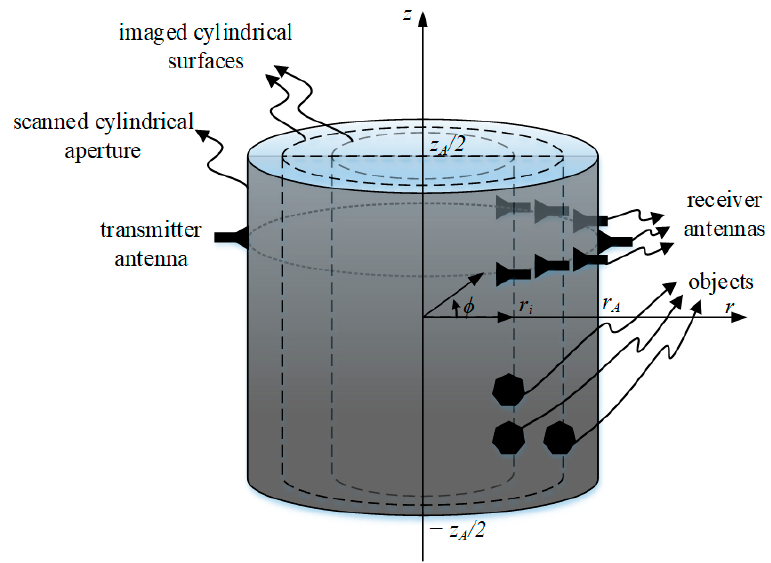
Figure 1. The proposed microwave imaging setup in which a transmitter antenna scans a cylindrical aperture together with an array of receiver antennas. The images are then reconstructed over cylindrical surfaces with radii r = r i .